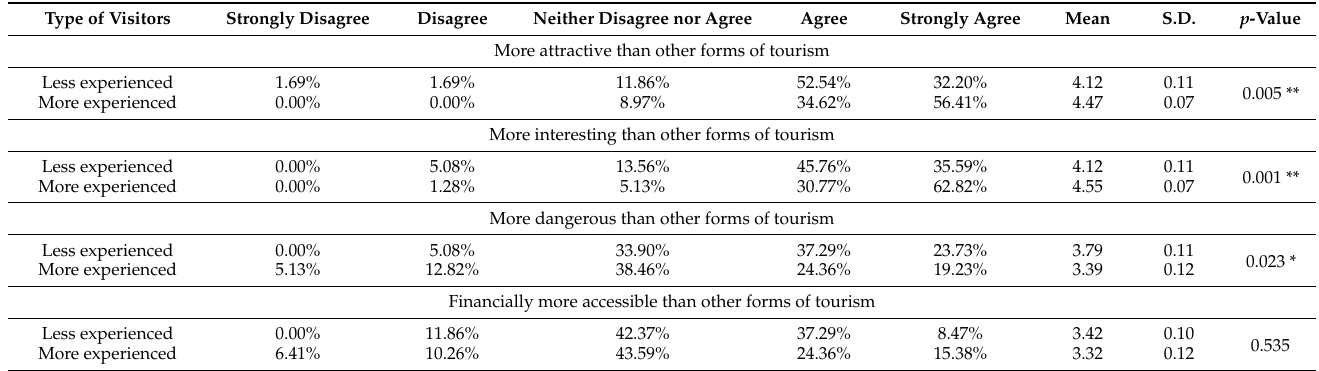
Table 6. Perception of adventure tourism compared to other forms of